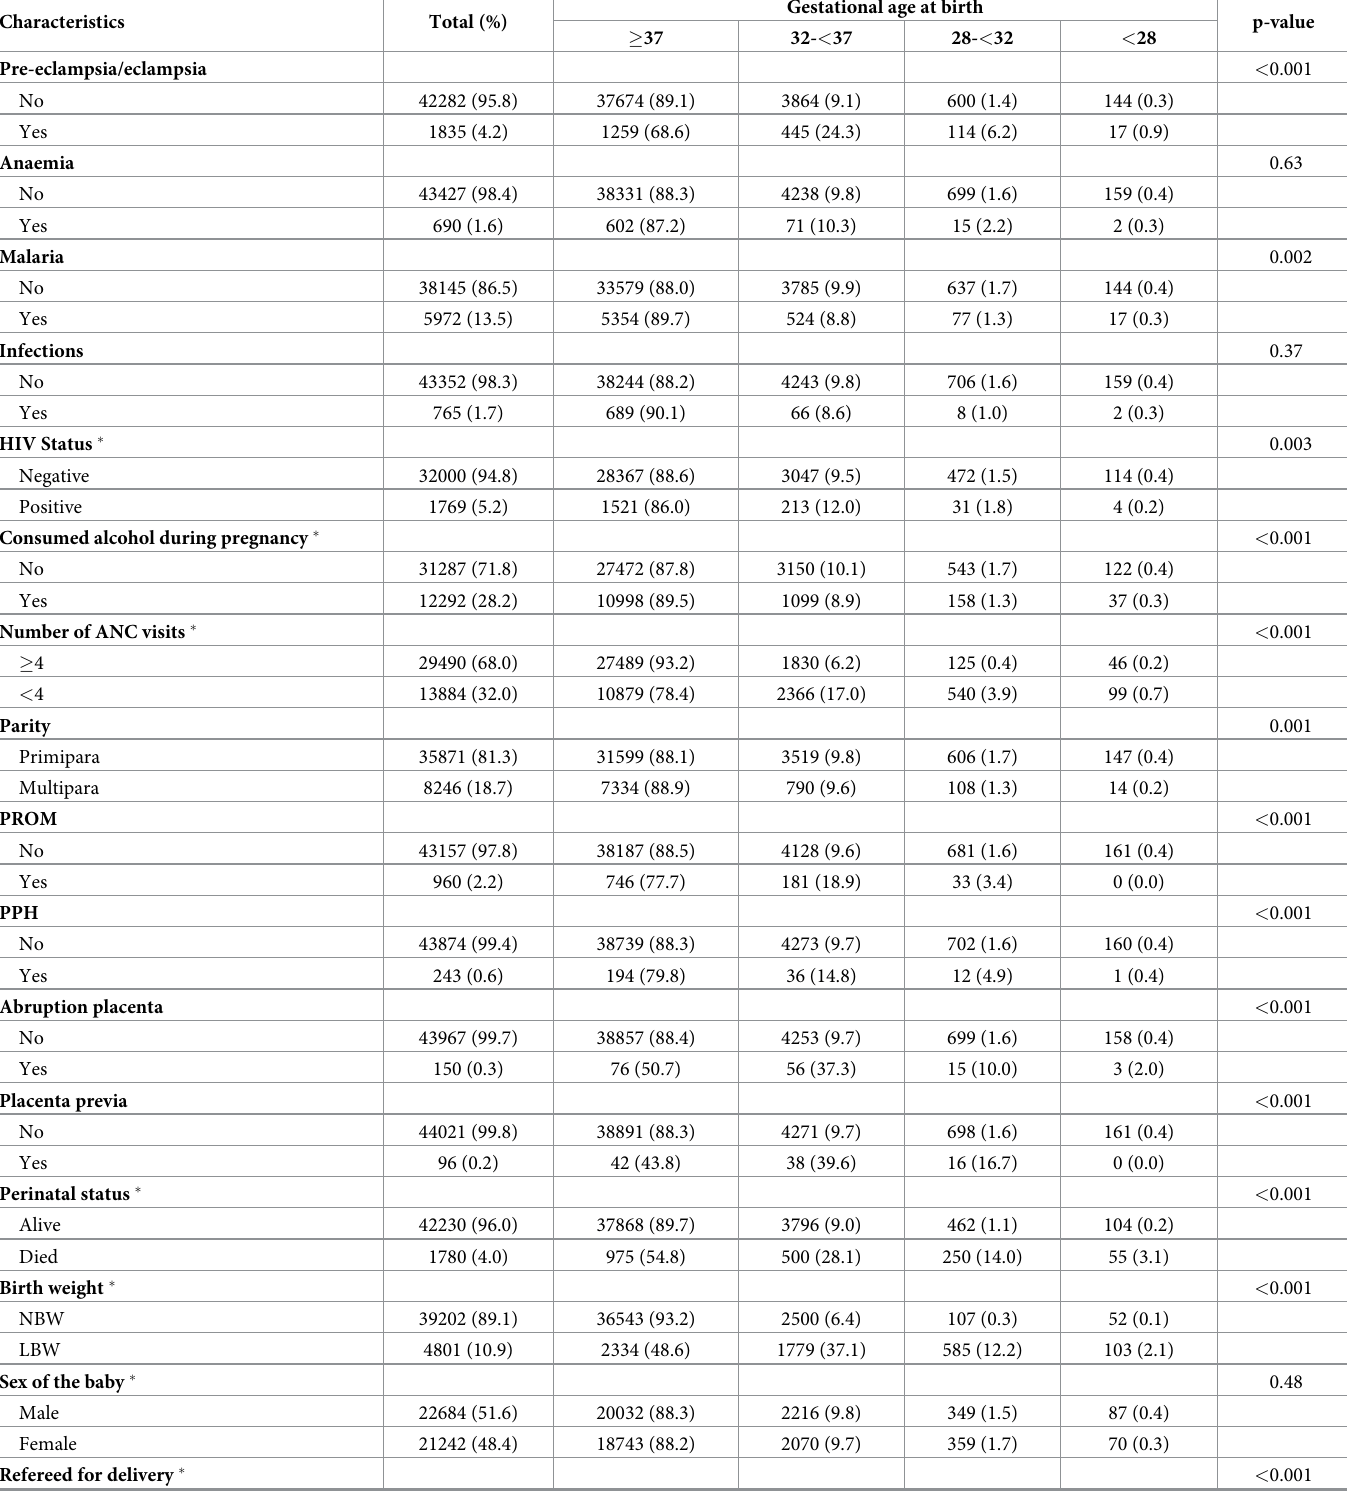
Table 2. Diseases and complications during pregnancy and delivery by gestational age categories (N = 44,117).